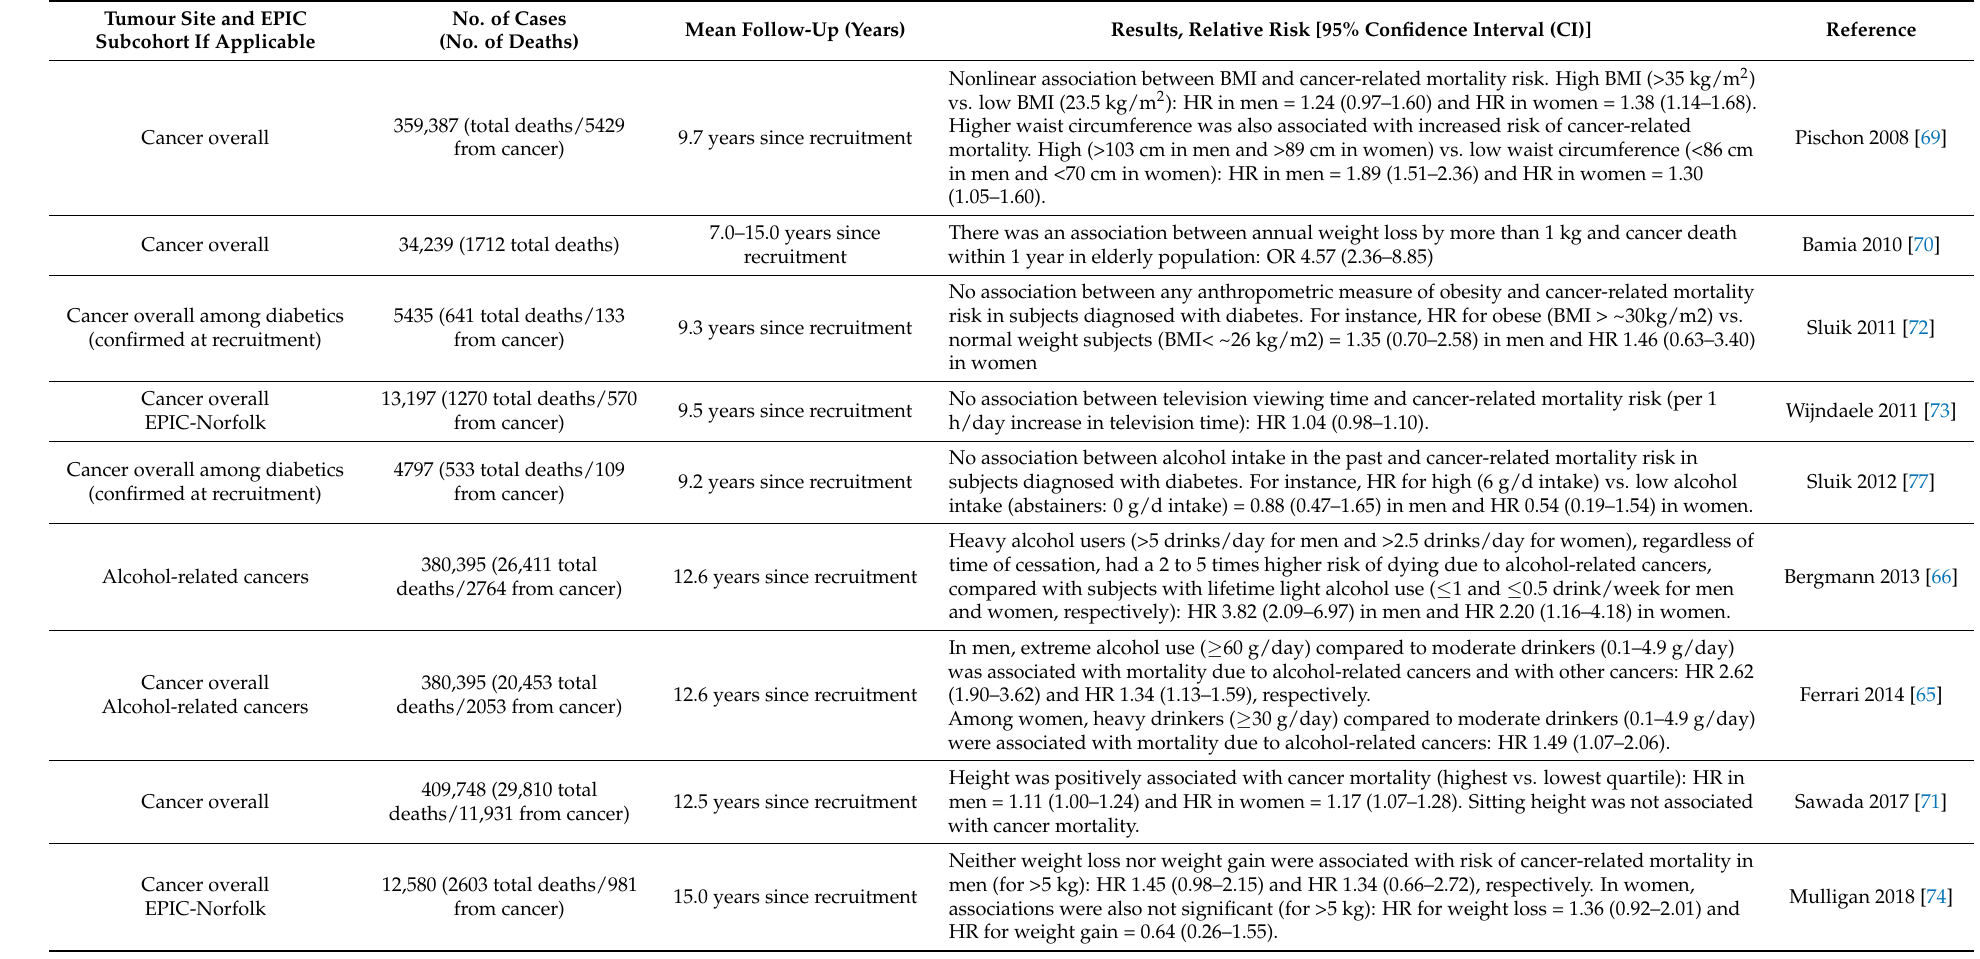
Table 4. Other lifestyle exposures investigated as potential risk factors for cancer mortality in the EPIC